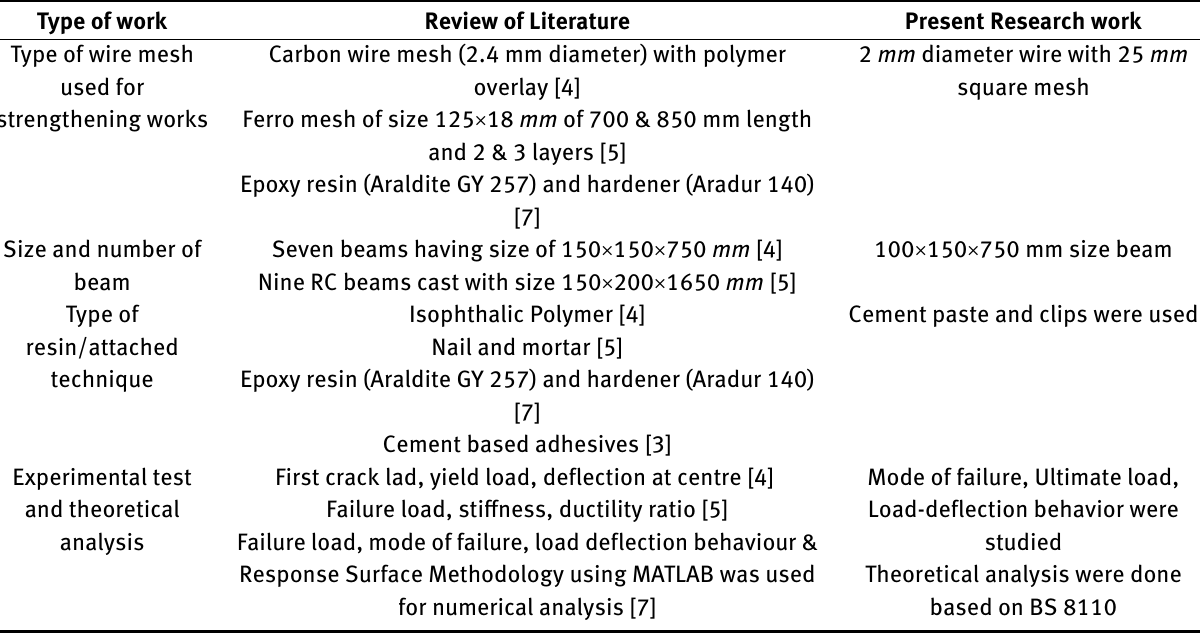
Table 1: Beam & Ferro cement/FRP laminate dimensions, strengthening techniques adopted and summary of test results. Type of